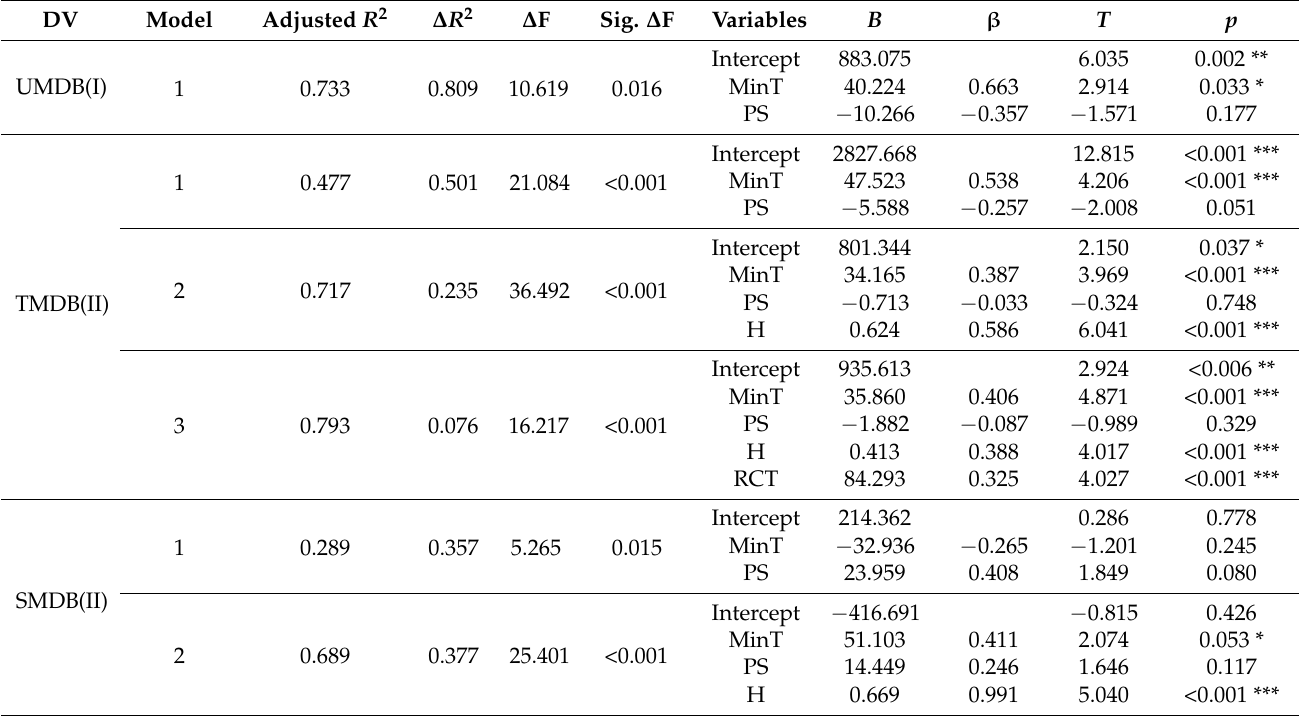
Table 1. Hierarchical multiple regression summary for deciduous broad-leaved forest on the mountains without climatic treeline in the east monsoon realm of China.